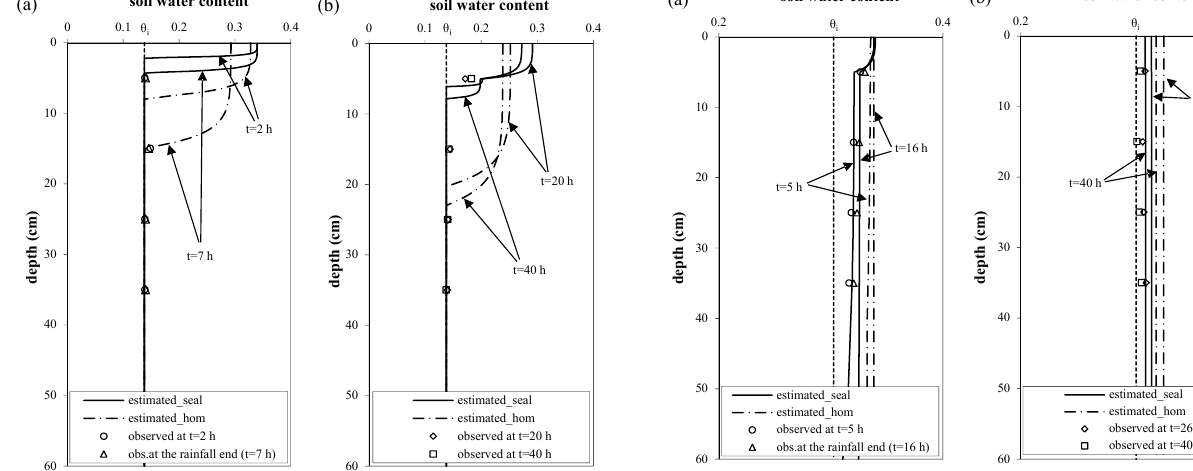
Fig. 7. Water content profiles simulated by the adopted model for homogeneous soil and specific values observed at different depths during (a) the infiltration stage, (b) the redistribution stage. Event 5 of Fig. 2 (see also Table 2). Saturated hydraulic conductivity 2mmh − 1 .